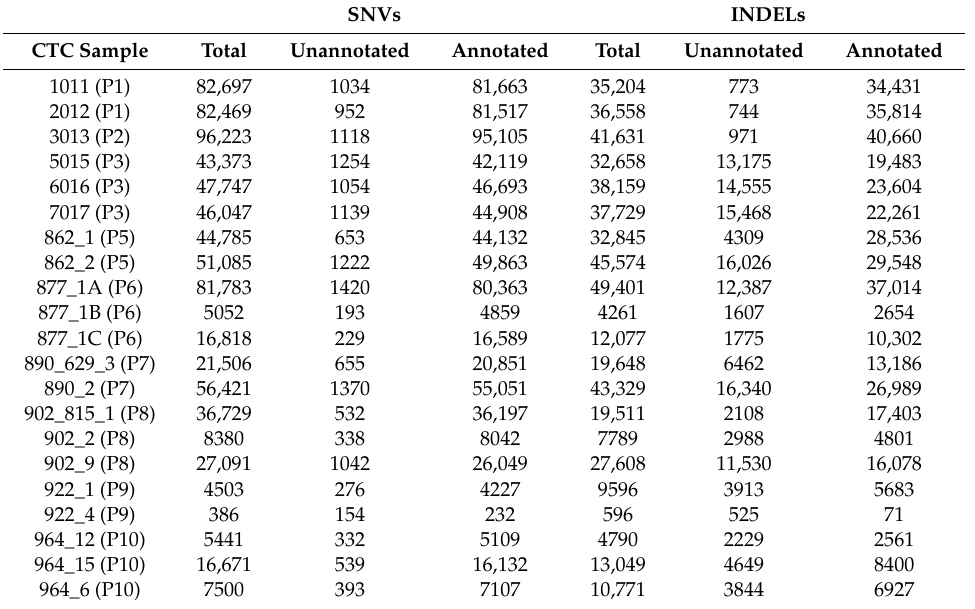
Table 3. Single nucleotide variants (SNVs) and insertion-deletions (Indels) count by CTCs and annotation into dbSNP [43] and COSMIC [50] databases.